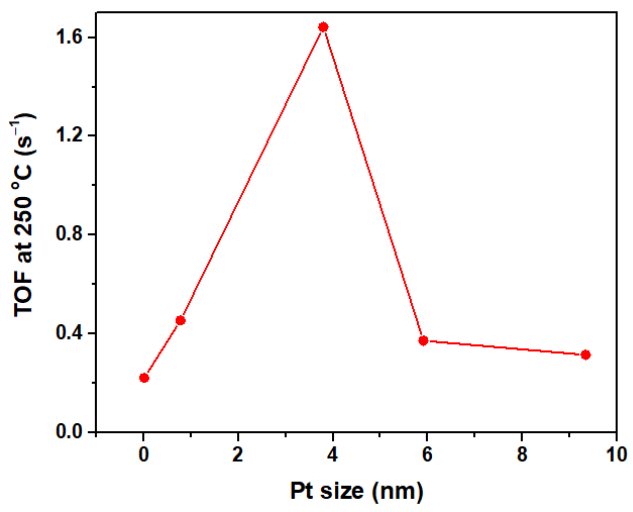
Figure 12. Turnover frequency at 250 °C of the Pt/CeO 2 samples with different Pt particle sizes. Adapted from Ref. [26]. Copyright© 2021, Elsevier.